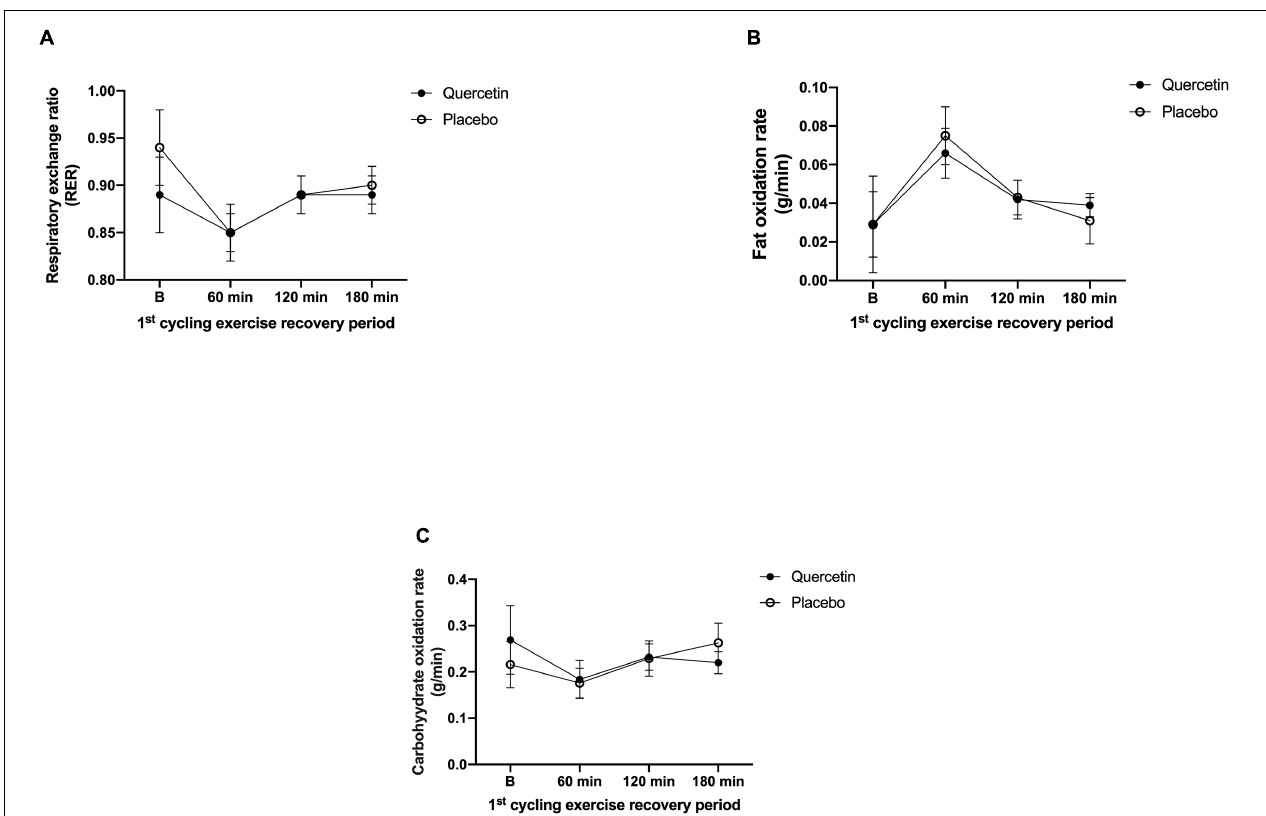
FIGURE 4 | Respiratory exchange rate (A) , fat oxidation rate (B) , and carbohydrate oxidation rate (C) in (- • -) and quercetin trials (- ◦ -) placebo. B represents before the first cycling challenge; *Significant difference between quercetin and placebo ( p < 0.05). Values are expressed as mean ± SE, N =